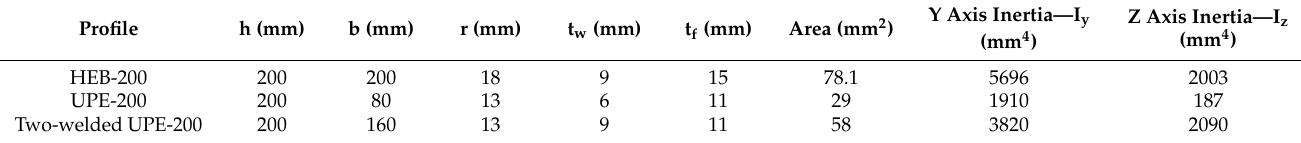
Figure 5. Mechanical characteristics of the profiles. Table 1. Mechanical characteristics of the profiles.